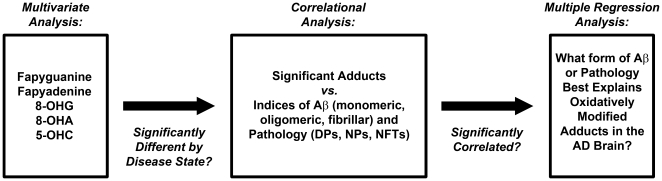
Flowchart depicting the steps comprising the data analysis.A directed analysis of the data was used to reduce the large data set to its significant components. A multivariate analysis determined which variables were significantly different in AD using PMI and age as covariates and gender as a variable; only significant variables were included in further analysis. A Spearman correlation was used to determine the relationships between the five RNA adducts of interest and the other measures of AD pathology. Finally, these significant variables were analyzed by stepwise multiple regression to determine if they predicted the changes in the RNA adducts.